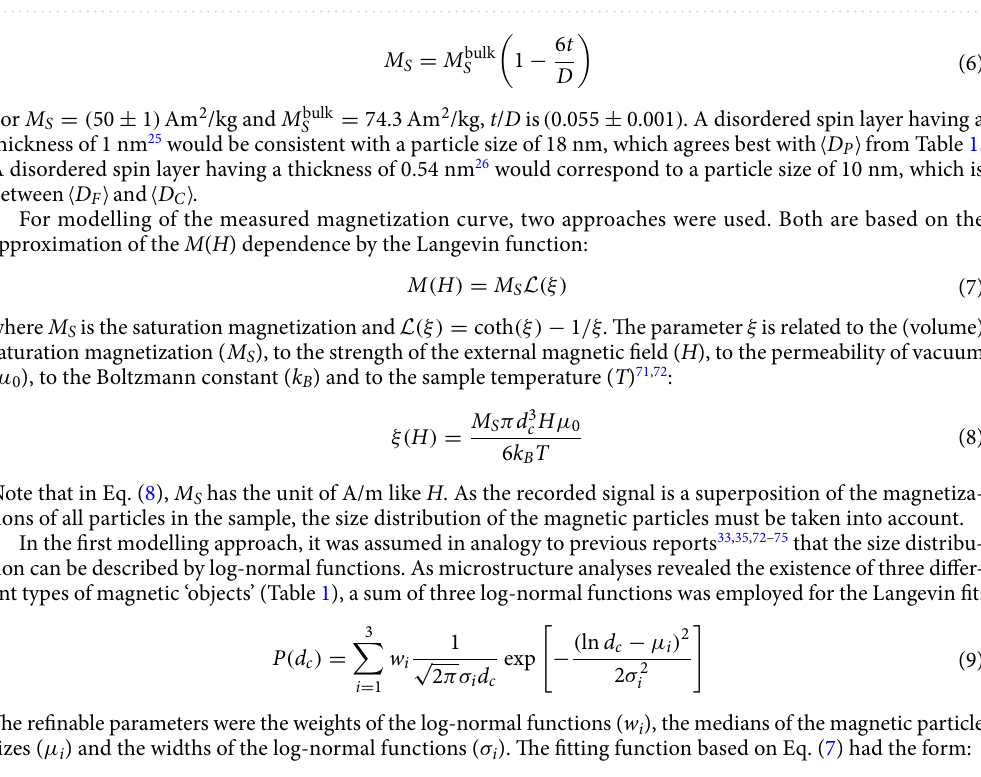
Figure 8. ( a ) Magnetization curve of the IONFs as measured by AGM (crosses) and the Langevin fits using three log-normal functions (solid blue line) and using the Kaczmarz method 70,71 (dashed red line). ( b ) Distributions of the magnetic particle size corresponding to the fits in panel ( a